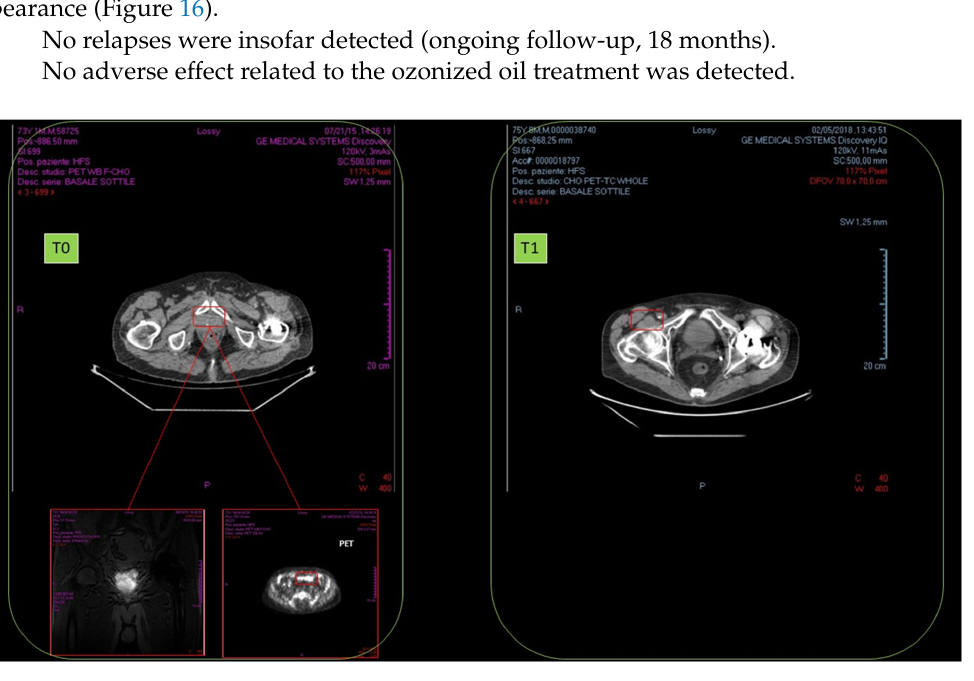
Figure 15. Prostate cancer histopathological analysis detecting poor signs of inflammation in the cancer parenchyma and surrounding tissues despite the high malignancy grade (Gleason 9) after HOO treatment. The presence of tumor-associated macrophages was not detected at all, at variance with the usual aspect of this cancer type (magnification 100×).